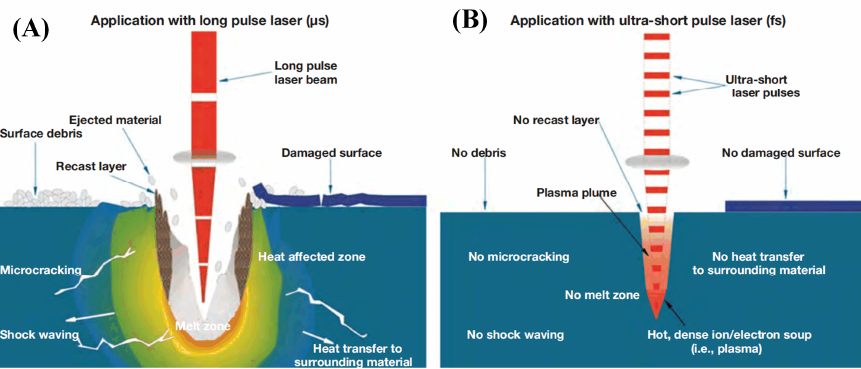
Figure 6. Schematic processing comparison of microsecond to femtosecond lasers: ( A ) long-pulse laser and ( B ) femtosecond laser processing [42].